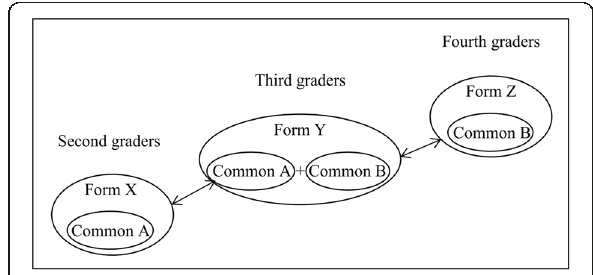
Fig. 1 Common-Item Nonequivalent Groups ’ Design (Adapted from Kolen & Brennan, 2014,